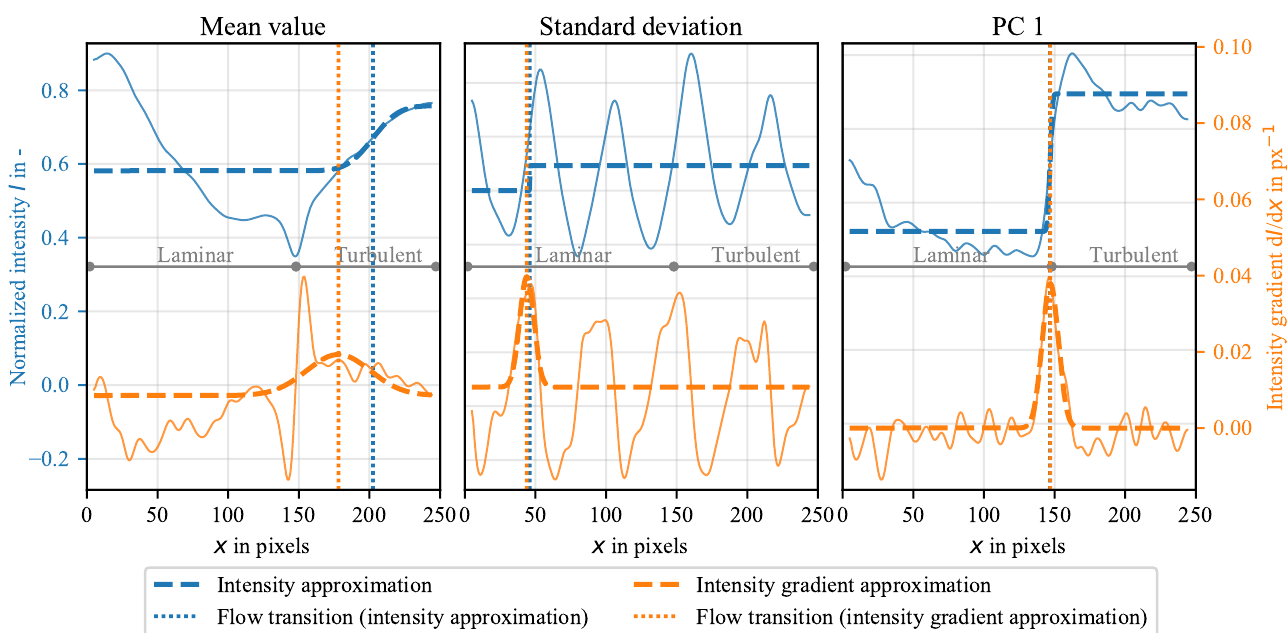
Figure 9. The intensity profile (blue line), intensity gradient profile (orange line) along the white dotted line in the temporal mean value, temporal standard deviation and PC 1 flow visualization in Figure 8. The approximation of the intensity profile (blue dashed) and intensity gradient profile (orange dashed), respectively. The flow transition localization results of both methods are depicted with a vertical dotted line in the respective color. Different expressions of the intensity plateaus are visible in each profile with varying gradients between the plateaus. The most distinct expression of the two plateaus including a steep step between them exists in the PC